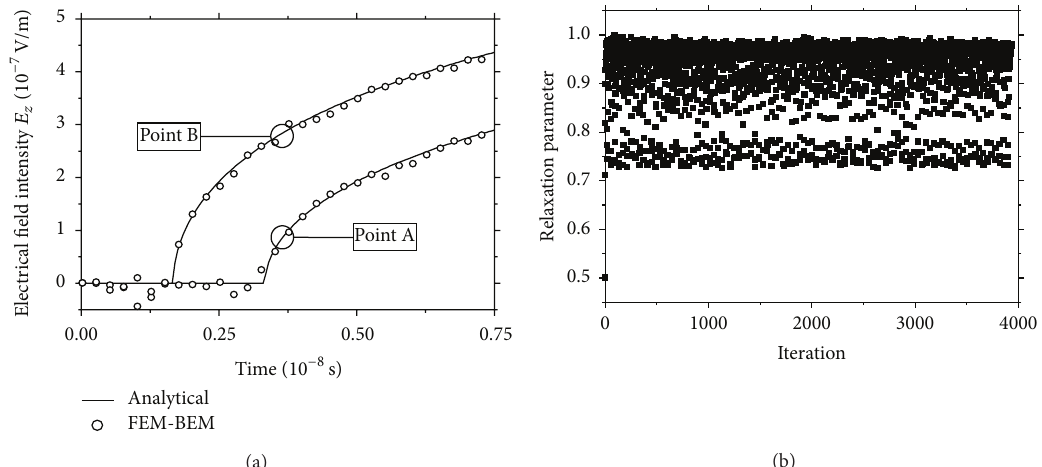
Figure 6: Results considering different time steps for each domain: (a) electric field intensity at points A and B; (b) optimal relaxation parameters for each iterative step.